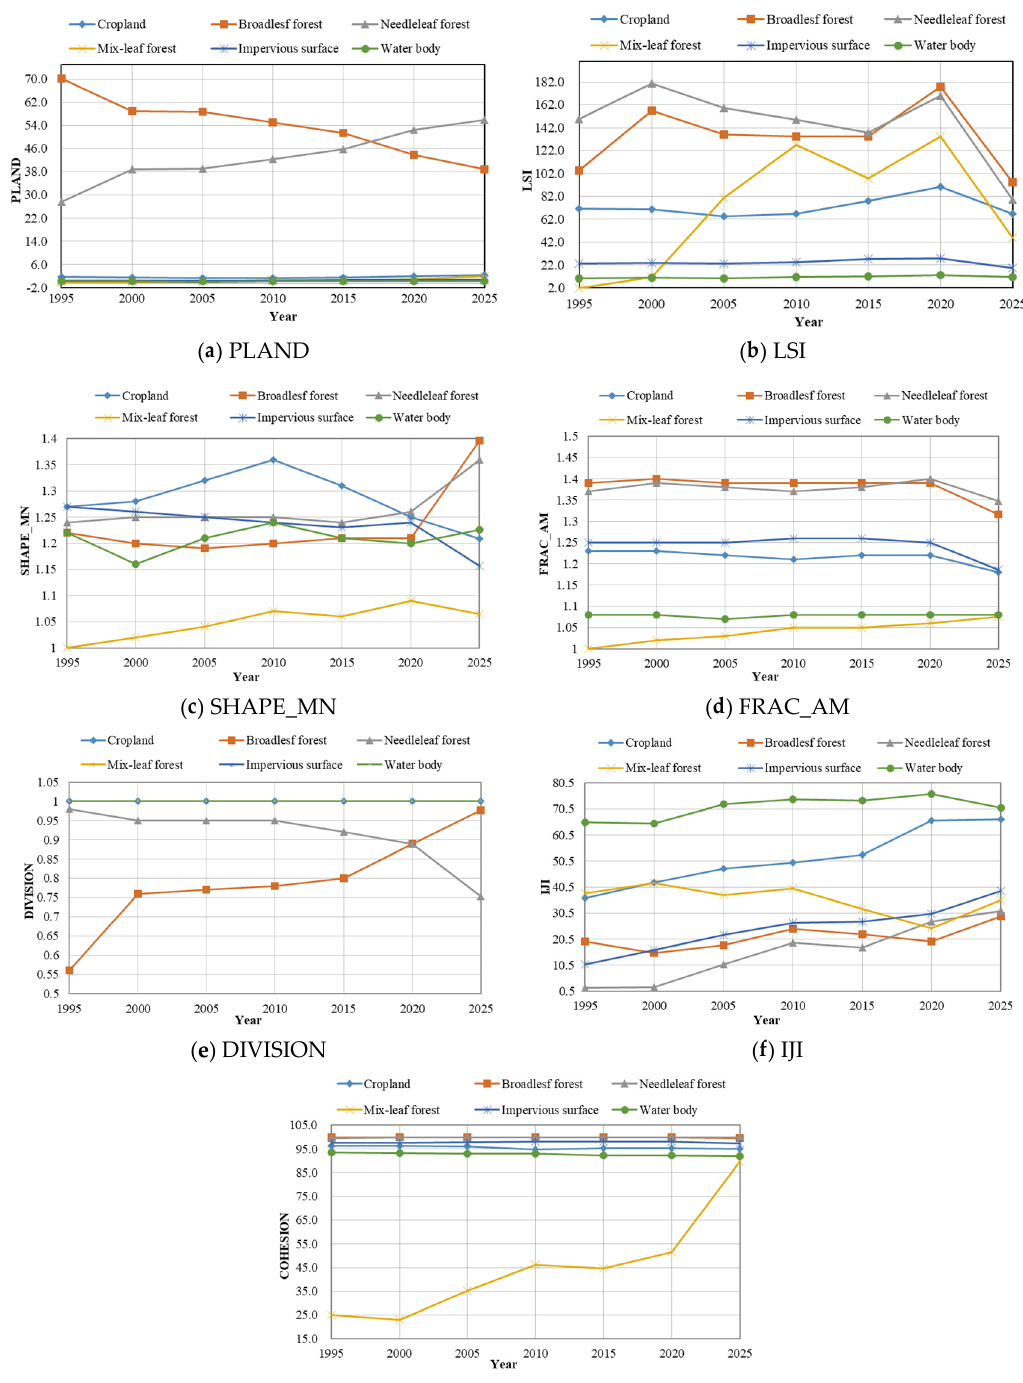
Figure 6. Dynamic Line Charts of Landscape Metrics for Di ff erent Land Cover Types.